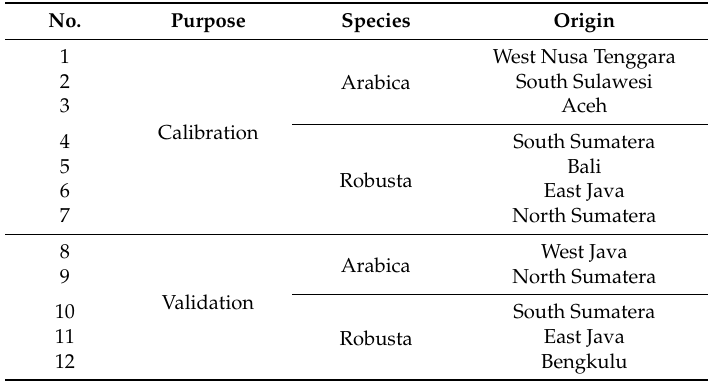
Table 1. Characteristics of the coffee samples including species and